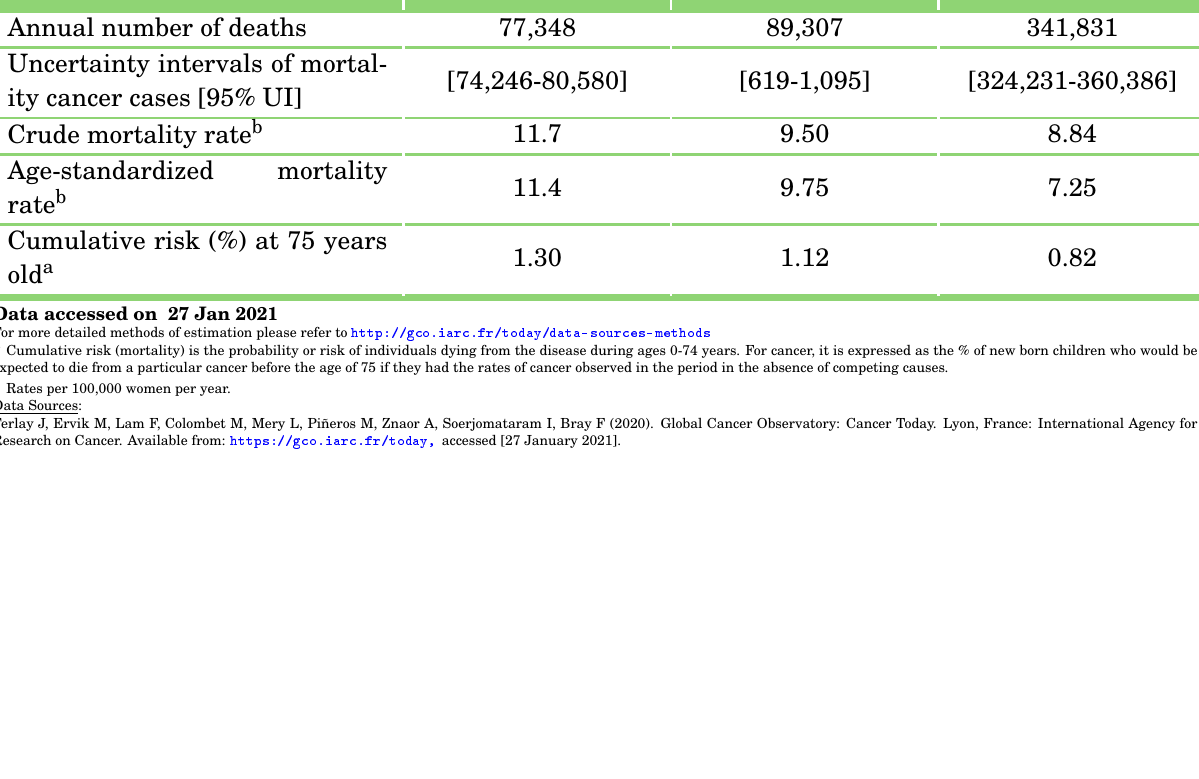
Table 5: Cervical cancer mortality in India (estimates for 2020)